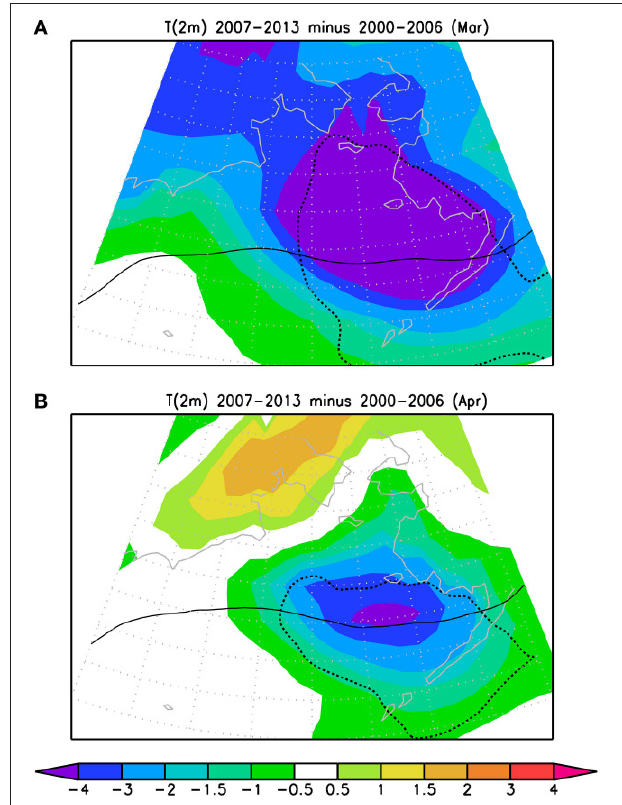
FIGURE 3 | Difference of surface (2 m) air temperature ( ◦ C) in March (A) and April (B) derived as mean during 2007–2013minus that during 2000–2006. Thin lines denote the mean surface air temperature of 0 ◦ C based on the period 2000–2006. The thick-dotted lines denote that the difference between 2007–2013 and 2000–2006 is significant at the 99% confidence level according to the Student t